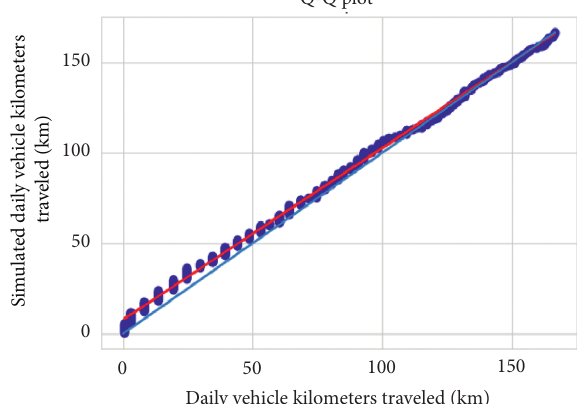
Figure 1: Q-Q plot of the simulated and original variable (daily vehicle kilometers